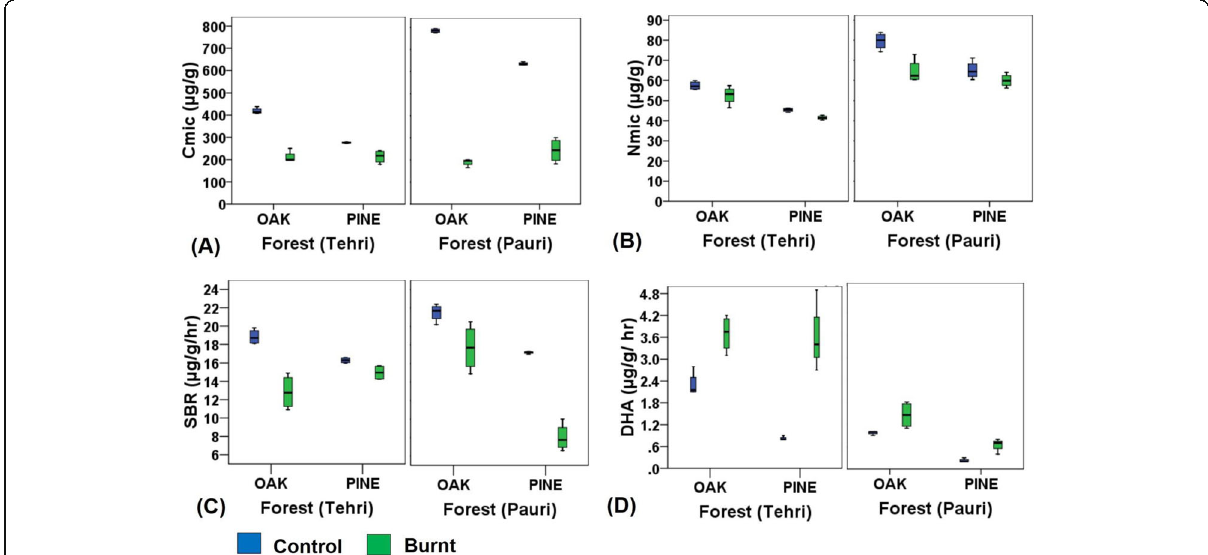
Fig. 2 Mean values of soil microbial properties at the control and burnt sites in two different forests ( C mic , soil microbial biomass carbon; N mic , soil microbial biomass nitrogen; SBR , soil basal respiration; DHA , dehydrogenase